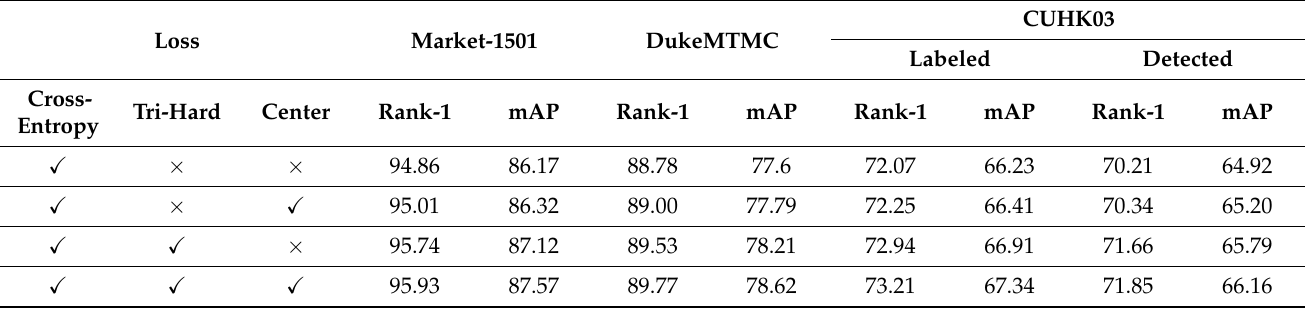
Table 5. Performance of Re-ID models under different loss functions ( × loss not employed, (cid:88) loss